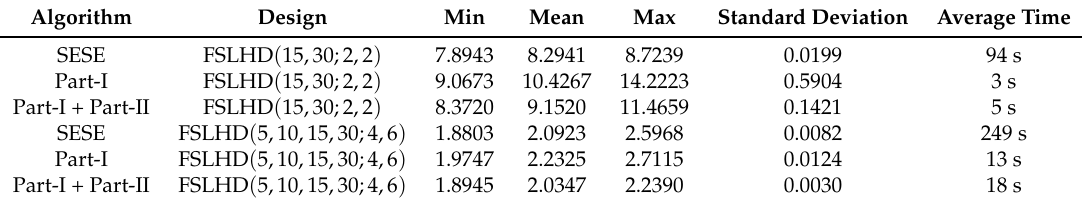
Table 1. Performance of the efficient two-part algorithm for repeating 100 times Algorithm